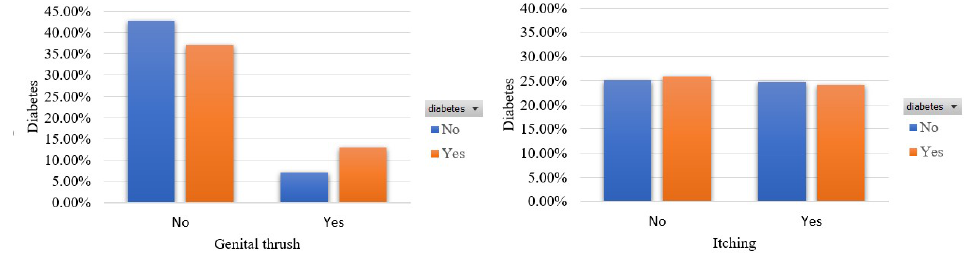
Figure 6. Participants’ distribution in terms of genital thrush and itching in the balanced dataset.